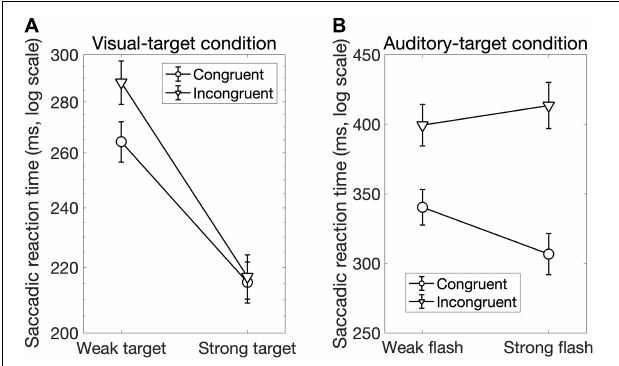
FIGURE 4 | (A) Interaction between the target saliency and audiovisual spatial congruency in the visual-target condition. The factor of the non-target saliency was averaged in this figure. There was a spatial congruency effect on the SRT when the target luminance was low, whereas there was no spatial congruency effect when the target luminance was high. (B) Interaction between the audiovisual spatial congruency and non-target saliency (luminance of the visual stimulus) in the auditory-target condition. The factor of target saliency was averaged in this figure. The result shows that the enhancement effect caused by the congruent visual stimulus was greater (black dots in this figure and thick arrow in Figure 2) compared to the distraction effect caused by the incongruent visual stimulus (white dots in this figure).